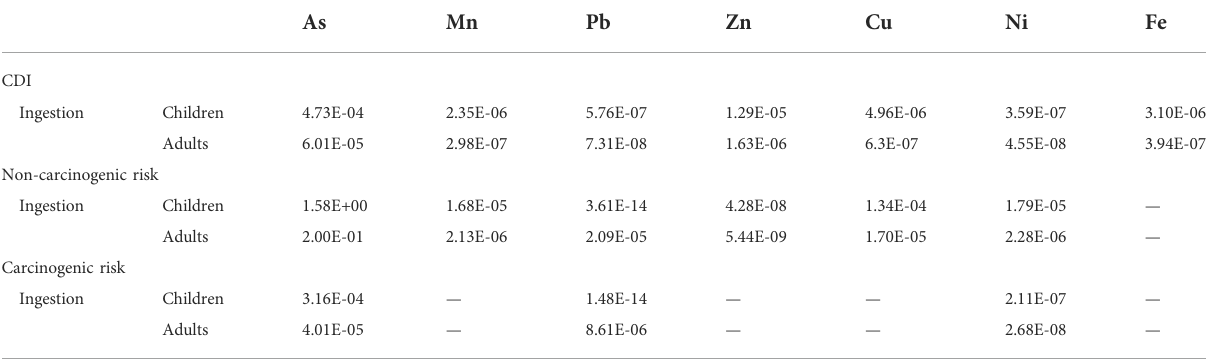
TABLE 3 Non-carcinogenic and carcinogenic risk of selected